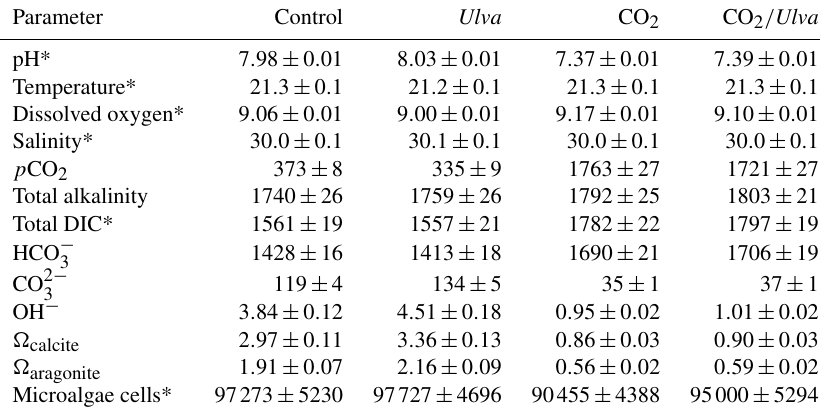
Table 1. Values of mean pH (total scale), temperature ( ◦ C), dissolved oxygen (mgL − 1 ), and salinity (gkg − 1 ), and final p CO 2 (µatm), total (cid:127) aragonite , and final microalgal cell counts of Isochrysis galbana and Chaetoceros muelleri (cellsmL − 1 ) at the end of the experiments ( n = 4 for all treatments). Values represent means ± standard error. Asterisks indicate parameters that were directly measured and not calculated. Data from individual experiments appear within Table